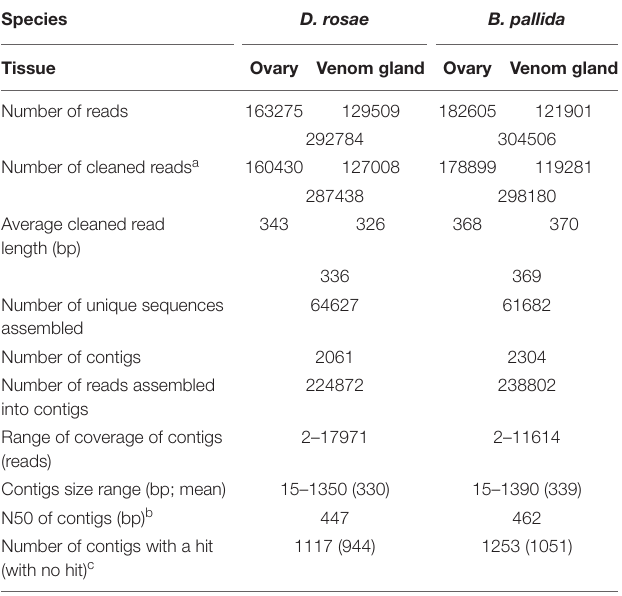
TABLE 1 | General features of the D. rosae and B. pallida